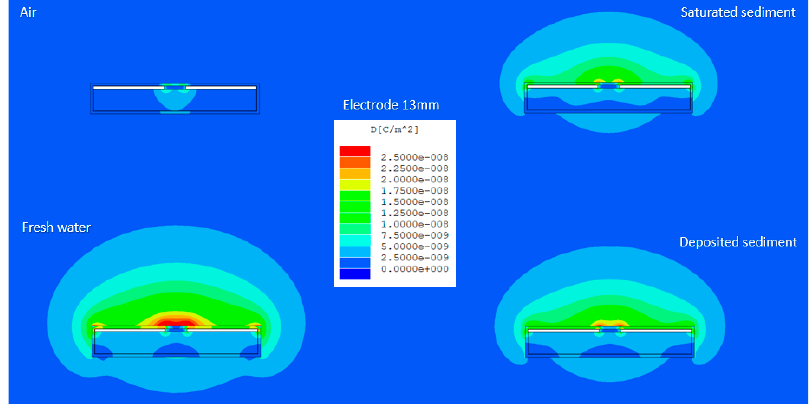
Figure 6. Typical magD and penetration of electric field obtained in air, saturated sediment, water and deposited soil simulated conditions for electrode length of 13 mm. The magD and penetration area of the generated field are increased and maximized for the simulated condition that corre- sponds to water environment. Figure 7a,b show the variation of the magD obtained for different simulated electrode